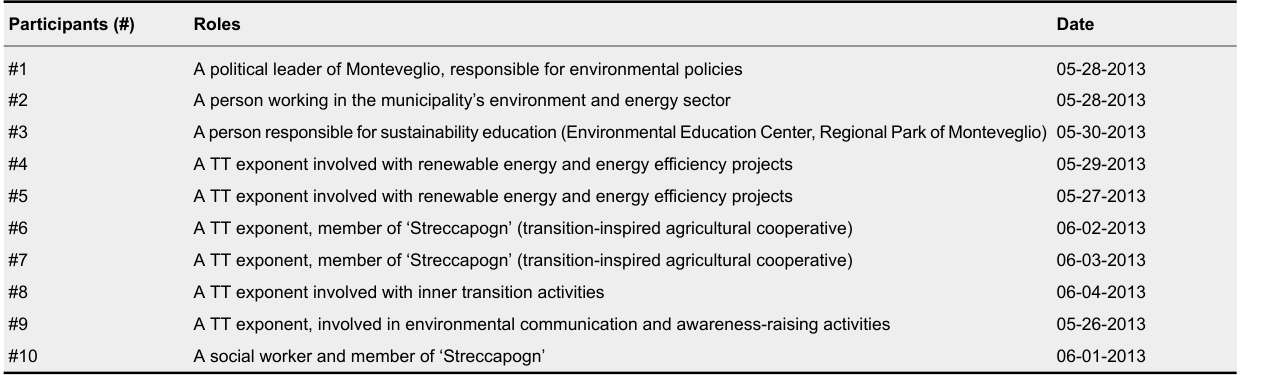
Semi-Structured Recorded Interviews With Key Informants. DateRolesParticipants